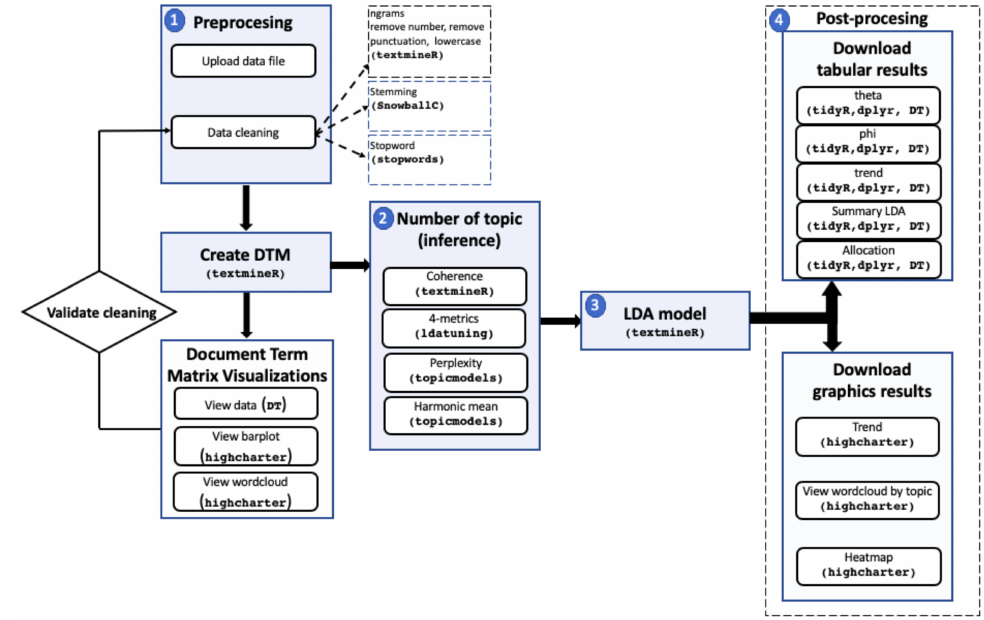
Figure 1. LDAShiny package outline. In parentheses are the main packages